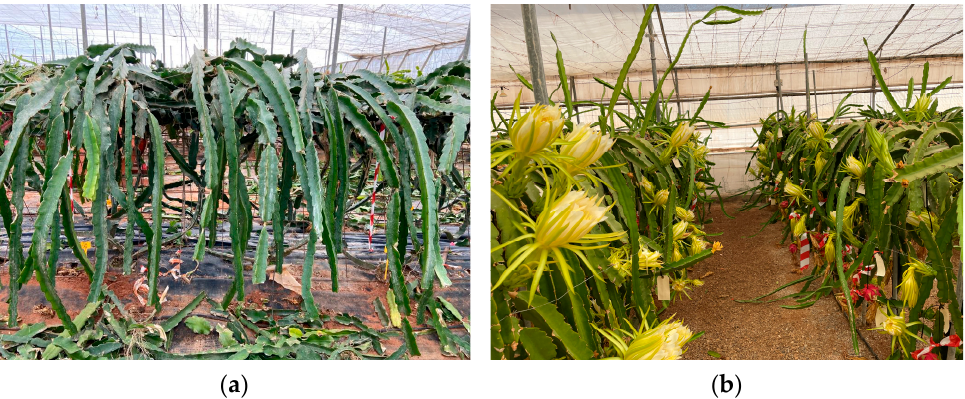
Figure 1. Details of the productive wall after pruning and partial view of the trellis system and the greenhouse of the first experiment ( a ). Flowering plants and partial view of the plants in bloom on a T-shaped structure under the greenhouse of the second experiment ( b ).